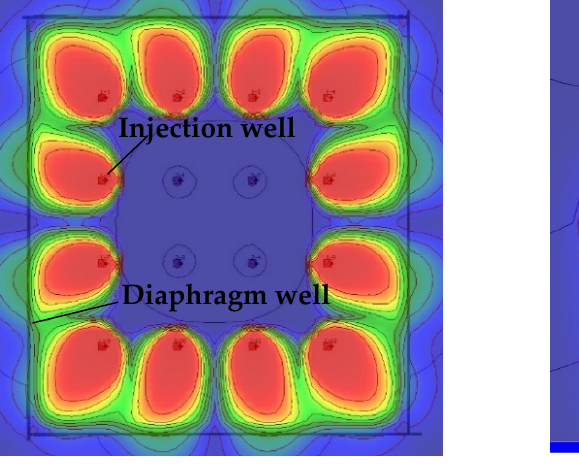
Figure 13. Migration of S. pasteurii after 4 days in condition 3: ( a ) Horizontal; ( b ) Vertical.